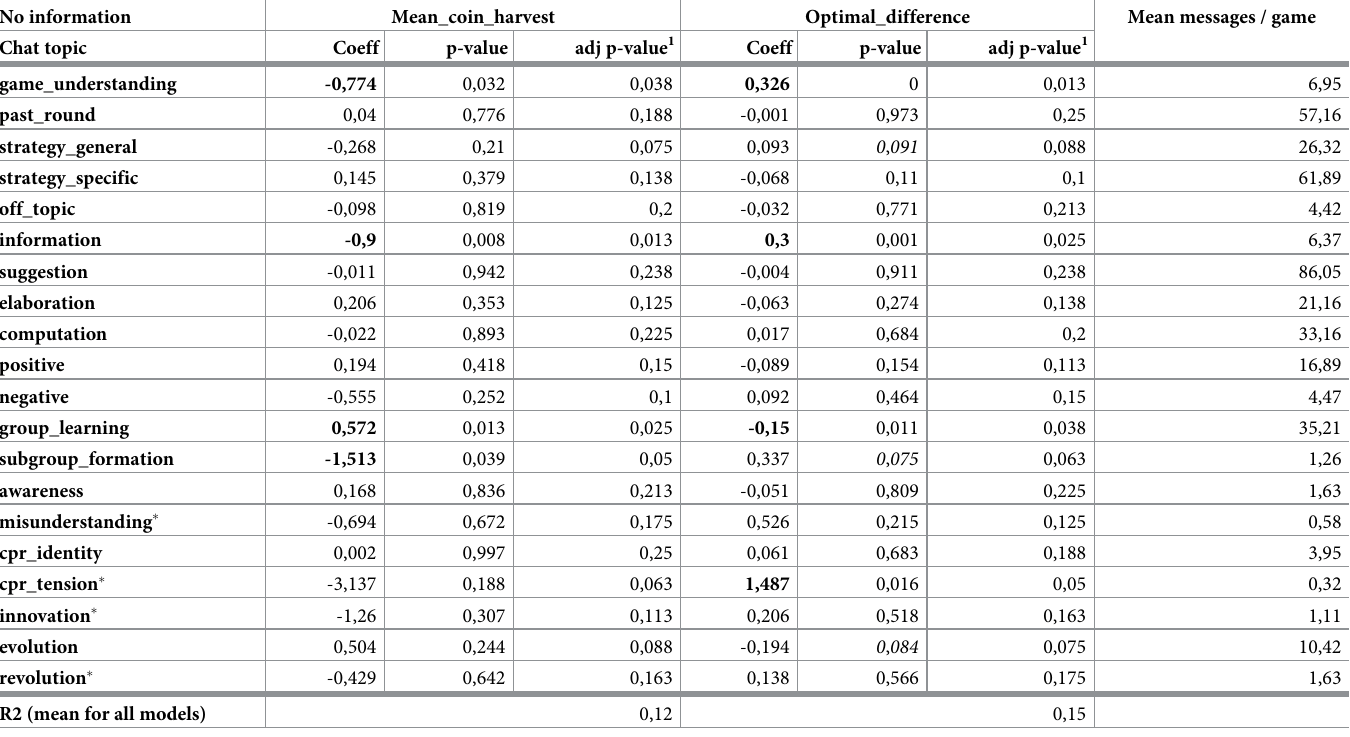
Table 5. Treatment D, the performance effect of the number of topical chat messages for any given